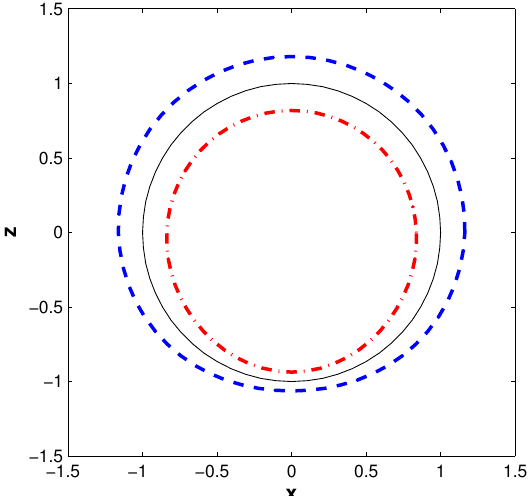
Figure 5. The shape of the bubble at the moments of the largest expansion (dashed line) and the greatest compression (dot-dashed line). For comparison the bubble equilibrium shape is shown by the solid line. All length-dimensional values are normalized to the bubble equilibrium radius R 0 . The bubble is located at the distance h = 1.5 R 0 from the rigid bottom. When calculating the dependencies shown